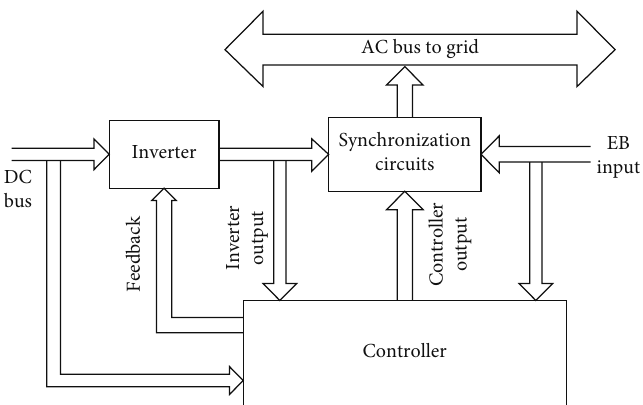
Figure 9: Control scheme for inverter and synchronizer